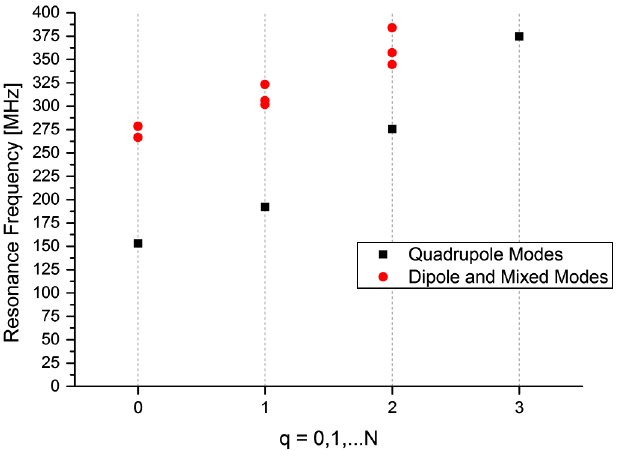
FIG. 17 (color online). The dispersion relation of the FNAL RFQ up to 400 MHz calculated by MWS. The first two modes are quadrupole modes and the first dipolelike mode can be found at about 125 MHz above the operating